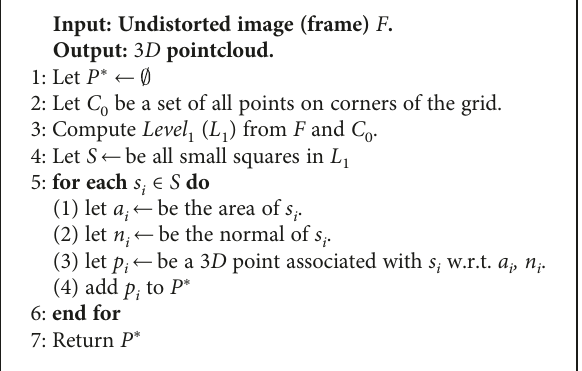
Algorithm 3: Computing the di ff erence map between reference image and current image.